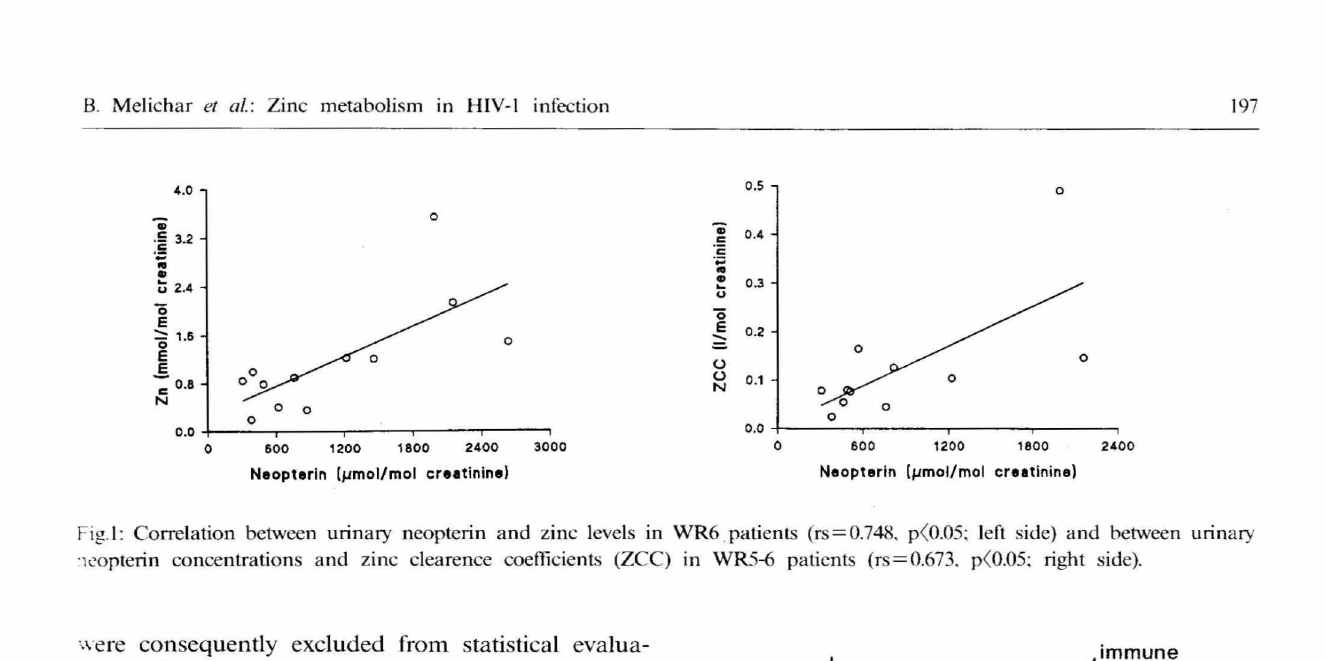
\\ere consequently excluded from statistical evalua cion, urinary zinc levels were high (3.69 and 2.14 rnmol/mol creatinine, respectively), although serum zinc value was low (9.9 flmol/l) in the patient with less pronounced urinary zinc excretion.